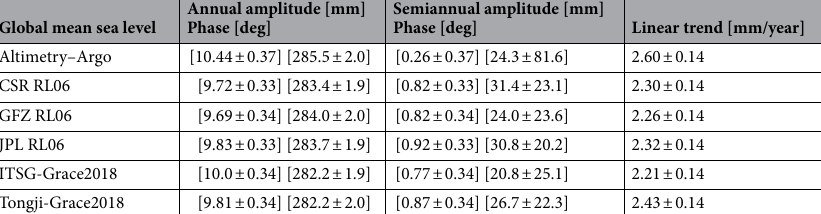
Global mean sea